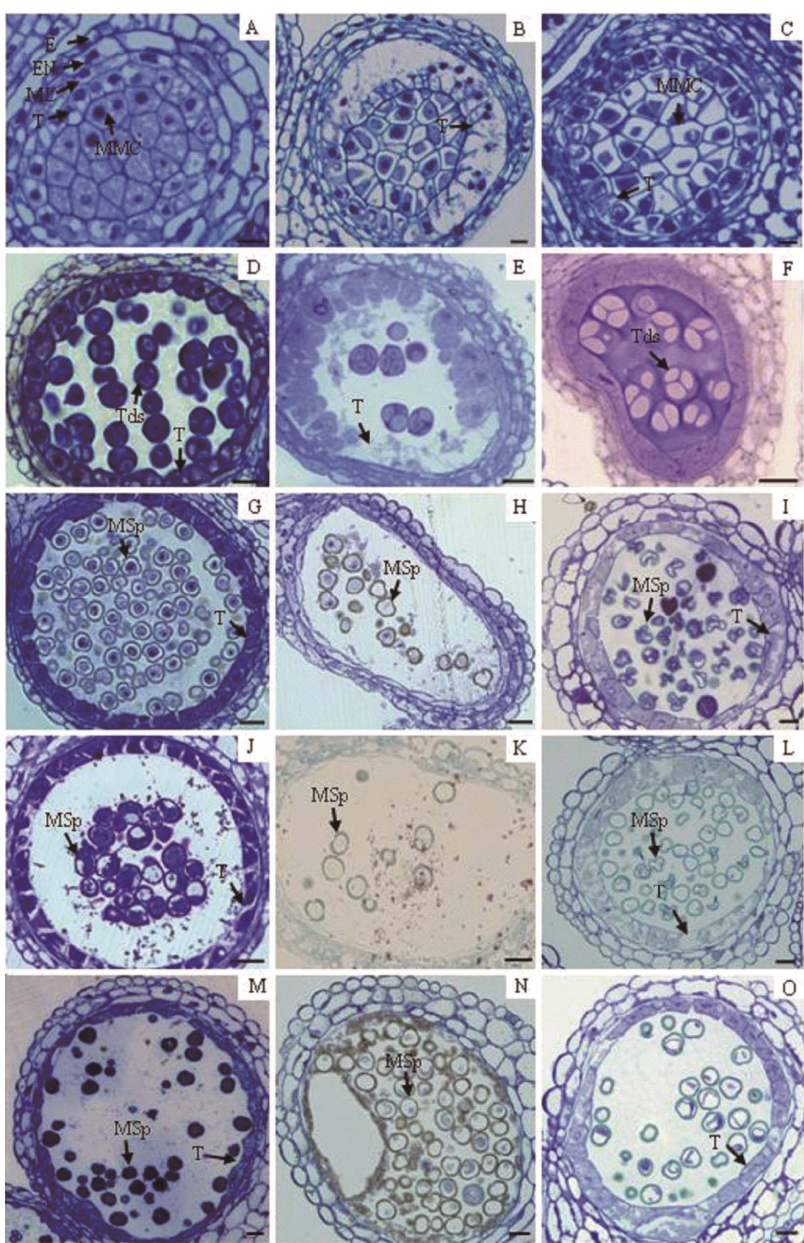
Figure 2. Comparison of the cytological structure of anthers from control plants and from MES-treated plants throughout pollen developmental stages. (A) Normal anthers of control plants at the pollen mother cell (PMC) stage containing microspore mother cells (MMCs) in the centre and four somatic wall layers: epidermis (E), endothecium (EN), middle layer (ML) and tapetum (T). (B) Type-I structure of anthers of MES- treated plants at the PMC stage containing MMCs with condensed bulk in the centre and partial degenerating tapetal cells. (C) Type-II structure of anthers of MES-treated plants at the PMC stage containing MMCs and intact tapetal cells both with condensed bulk in the centre. (D) Normal fertile anther of control plants at the tetrad stage showing tetrads (labelled Tds) and densely stained tapetal cells. (E) Type-I structure of MES-induced male sterile anther at the tetrad stage containing less densely stained tetrads and some loosely arranged tapetal cells. (F) Type-II structure of MES-induced male sterile anther at the tetrad stage containing less densely stained tetrads and tapetal cells. (G) Fertile anther of the control plants at the middle- microspore stage showing normal microspores and tapetum. (H) Type-I structure of MES-induced male sterile anther at the middle-microspore stage showing abnormal microspores (labelled Msp) and disappeared tapetum. (I) Type-II structure of MES-induced male sterile anther at the middle- microspore stage showing abnormal microspores and less stained tapetum. (J) Fertile anther from control plants at the vacuolated-microspore stage showing vacuolated microspores and degenerating tapetum. (K) Type-I sterile anther at the vacuolated-microspore stage showing unviable microspores and disappeared tapetum. (L) Type-II sterile anther at the vacuolated-microspore stage showing unviable microspores and less stained tapetum. (M) Fertile anther of control plants at the mature pollen stage showing mature pollen and degenerating tapetum. (N) Type-I structure of MES-induced male sterile anther at the mature-pollen stage showing unviable pollen and disappeared tapetum. (O) Type-II structure of MES-induced male sterile anther at the mature-pollen stage showing unviable pollen and less stained tapetum.